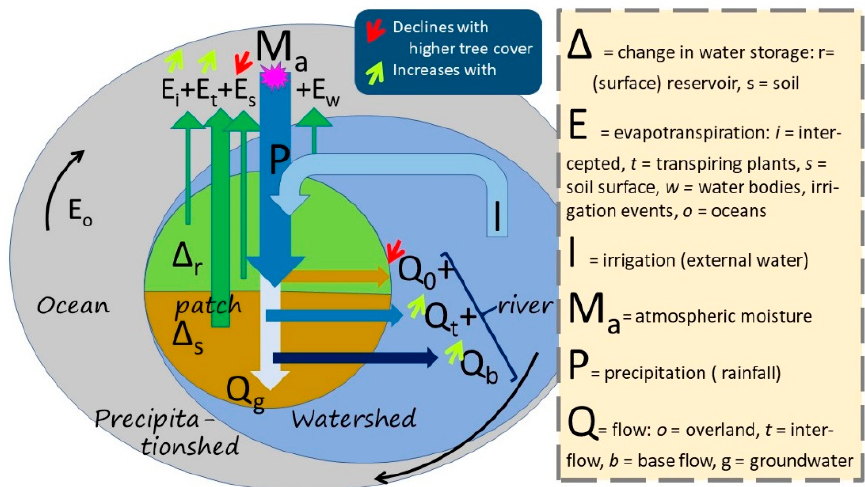
Figure 7. Basic elements of a water balance at patch, watershed and precipitationshed scale levels, that can form a biophysical basis for forest–water–people nexus games, with expected changes in terms with increasing/decreasing forest cover.